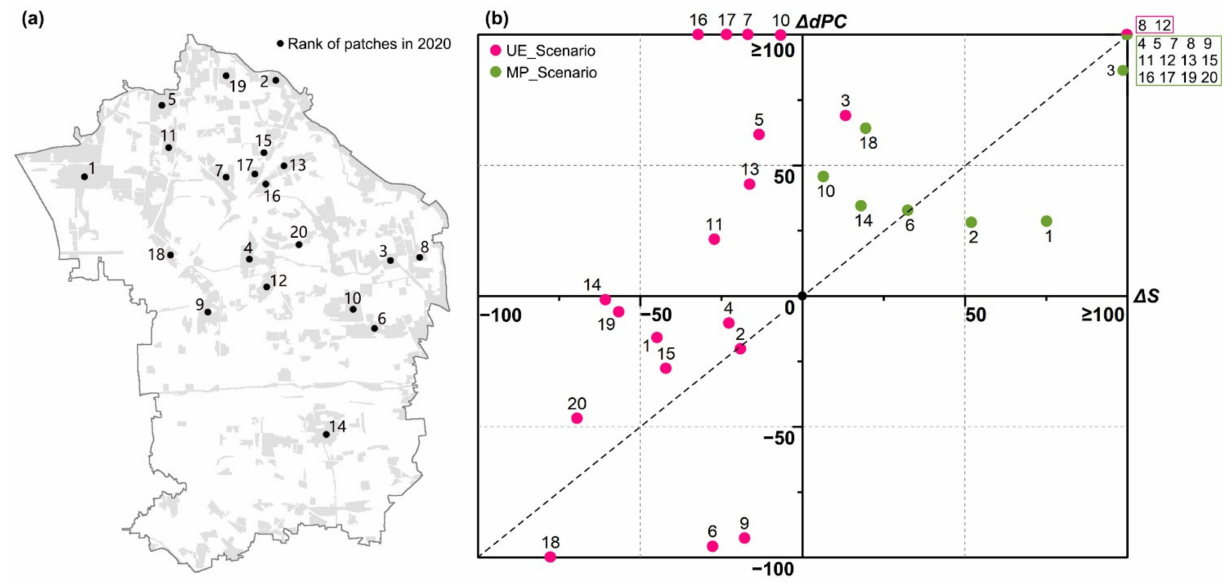
Figure 5. ( a ) Top 20 dPC index patches in the ecological network of Chaoyang District in 2020; ( b ) strategy quadrant diagram of patches based on ecological impacts under two scenarios. To facilitate the analysis, the range of the figure was set to ± 100 and values greater than 100 were simplified to the